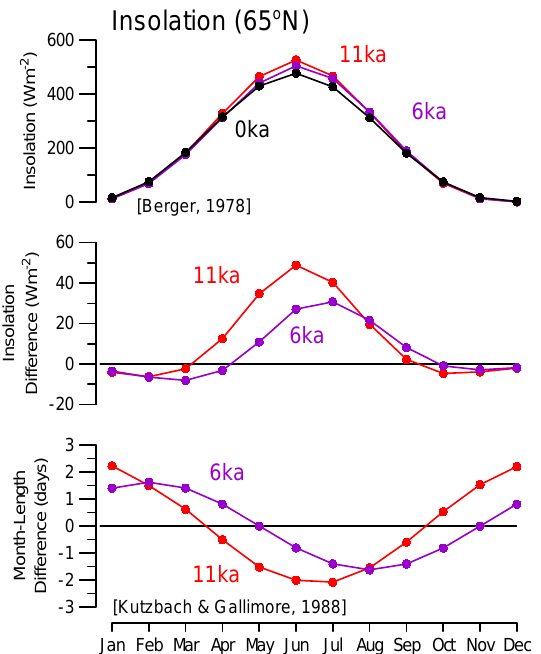
Figure 2. Monthly insolation at present (0ka), 6 and 11ka after Berger (1978; upper); insolation differences between present and 6 and 11ka (middle); month-length differences between present and 6 and 11ka (lower). The shorter summers and longer winters at 6 and 11ka (relative to present) arise from the elliptical orbit of the Earth and the precession of the equinoxes (see Kutzbach and Gallimore,